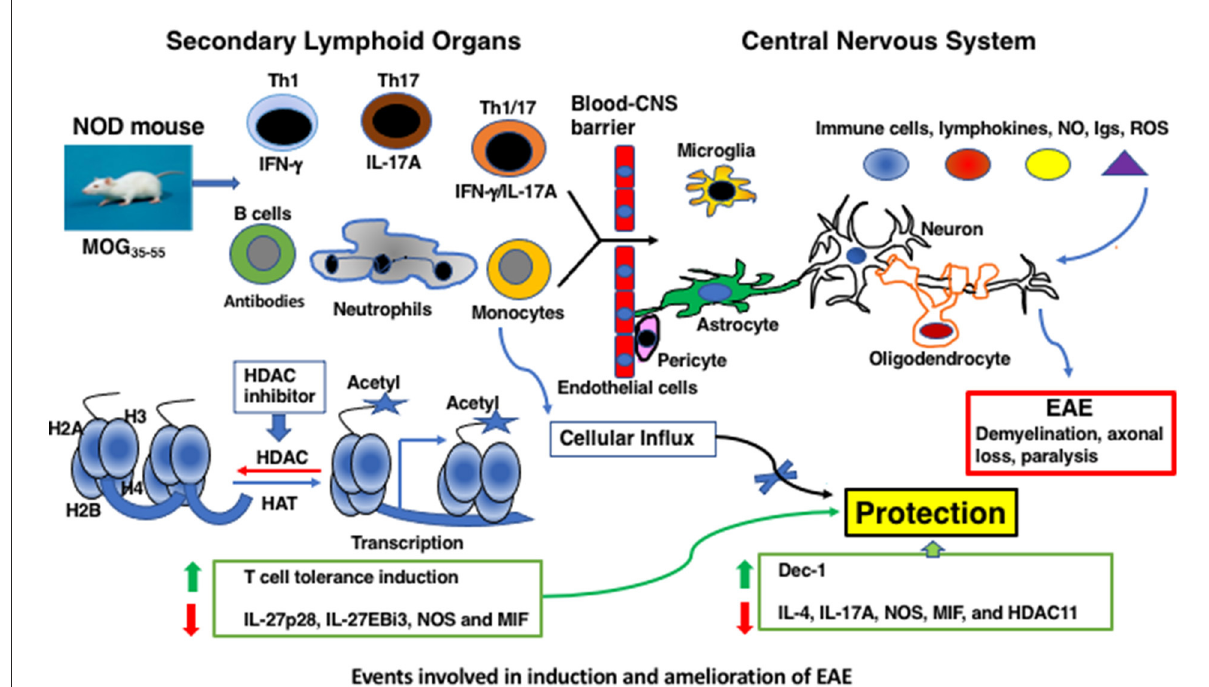
FIGURE1 Events involved in induction and amelioration of